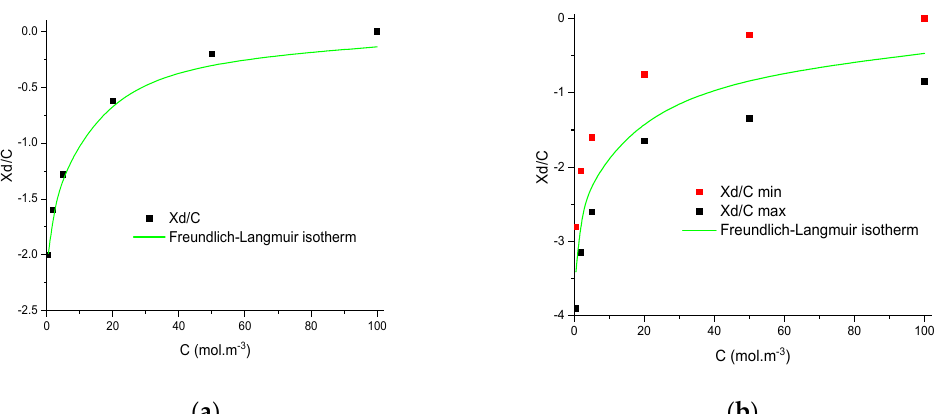
Figure 3. Evolution of minimum and maximum normalised volumetric charge density with concentration and the corresponding best-fitted Langmuir–Freundlich isotherms obtained by filtration of ( a ) NaI by the TiO 2 membrane and ( b ) NaF by the Na-mordenite membrane.